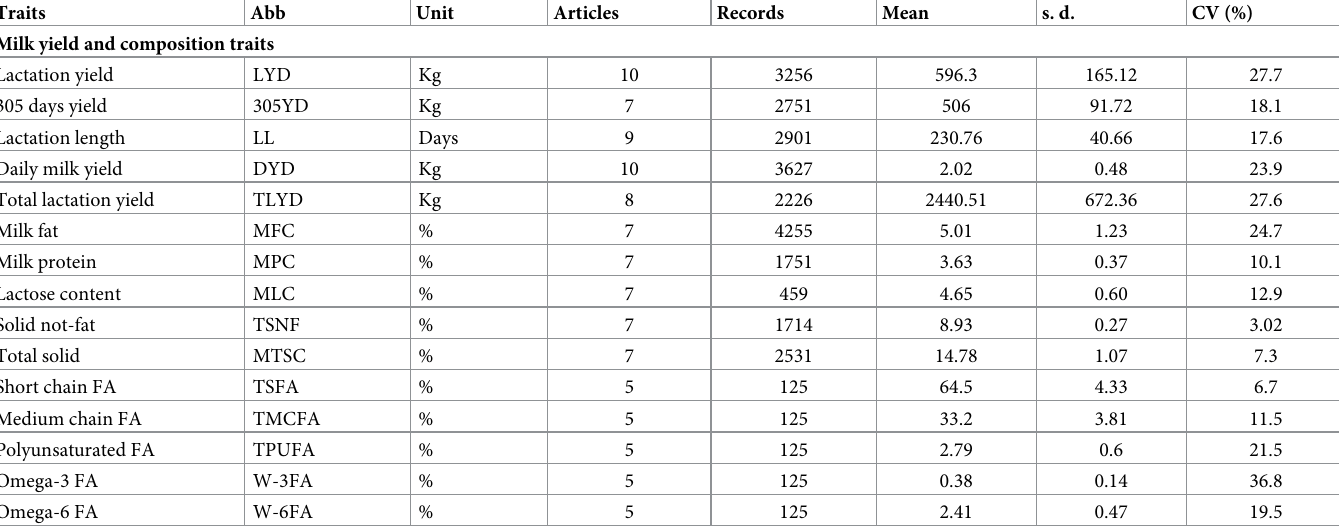
Table 3. Mean phenotypic traits of milk yield and composition in Boran cattle breed.